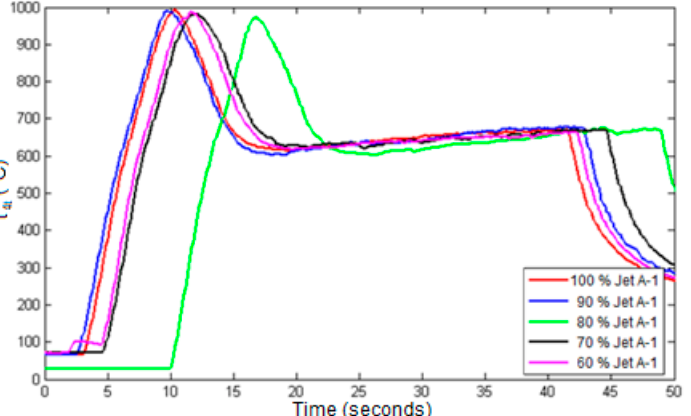
Figure 13. The graphical course of the change in the total gas temperature behind the gas turbine